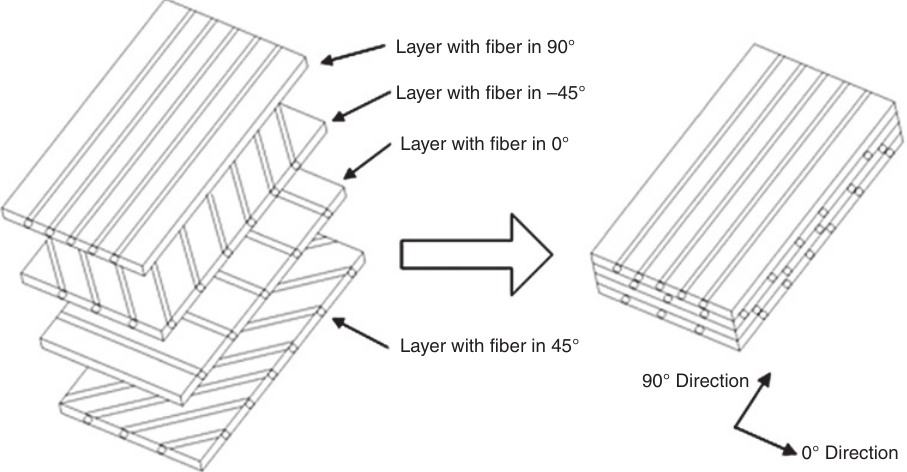
Figure 1: A typical laminated composite